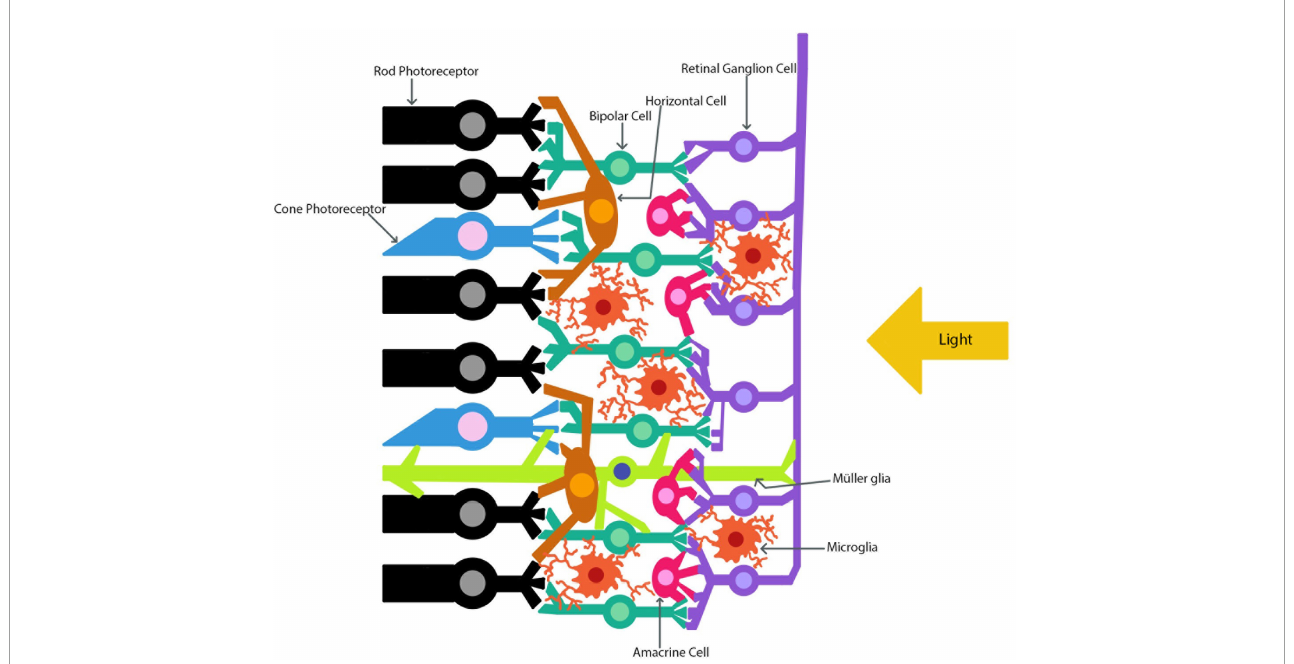
FIGURE1 The retinal layers. The path of light as it travels through the retina to the photoreceptors is indicated. The retinal ganglion cell axons combine to form the optic